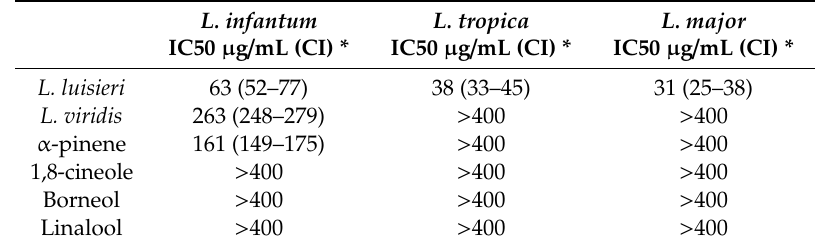
Table 2. Lavandula luisieri and Lavandula viridis essential oils activity and major compounds on Leishmania promastigotes